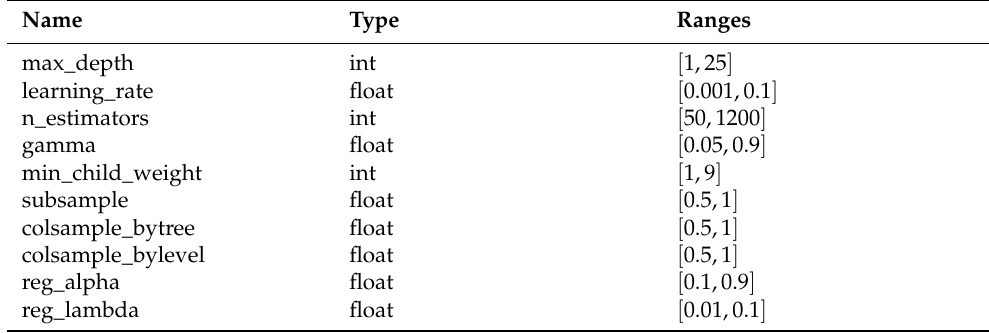
Table 2. Hyperparameters of